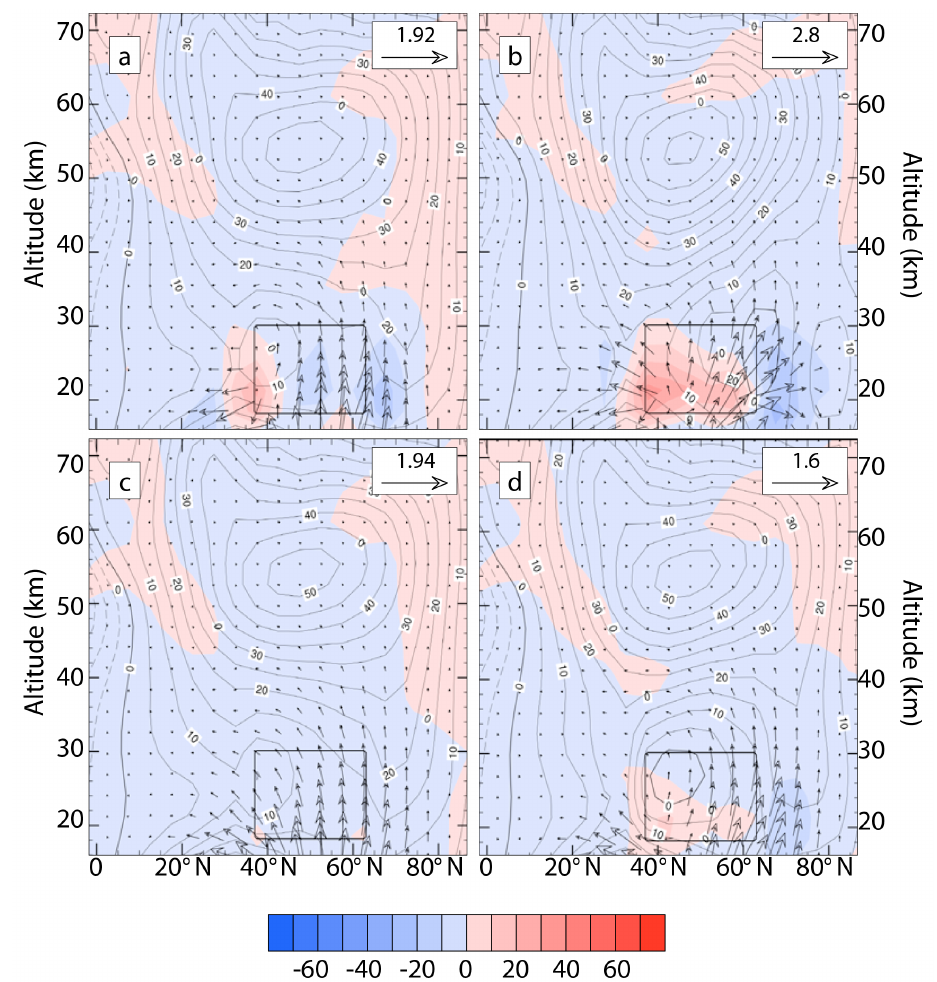
Figure 8. E–P flux vectors (kgs − 2 , arrows are scaled according the relative distances of the plot) and its divergence (colours in kgm − 1 s − 2 ) for the SSWbox simulation at 1 day (a) and 5 days (b) after the GWD injection, for SSWzon 1 day (c) and 5 days (d) after the GWD injection. In all panels contours of zonal-mean zonal wind from the respective simulation and time step are overlaid with an increment of 10ms − 1 . All panels are overlaid with selected contour of gravity-wave-induced zonal acceleration to illustrate the location of the artificial GWD.